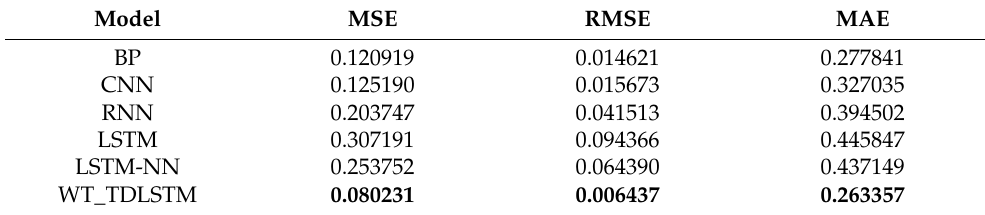
Table 4. Five randomized experimental average results of all the models on the commercial monthly electricity price dataset.